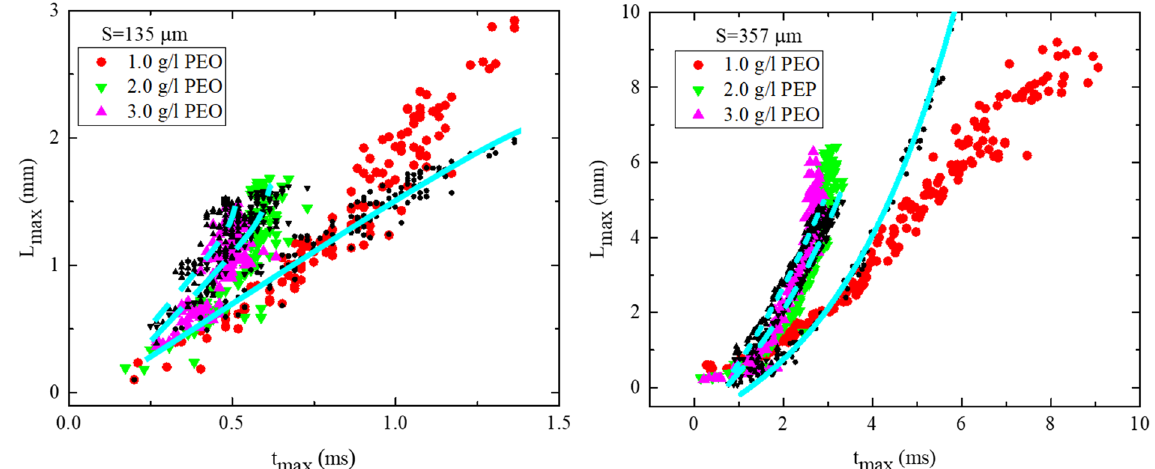
Figure 4. The maximum ligament size versus its corresponding time as defined in Fig. 3a. The black symbol shows the modeling result using L max = (� p − 1 / 6 π d trend. In the left figure S= 135 μm and in the right figure S=357